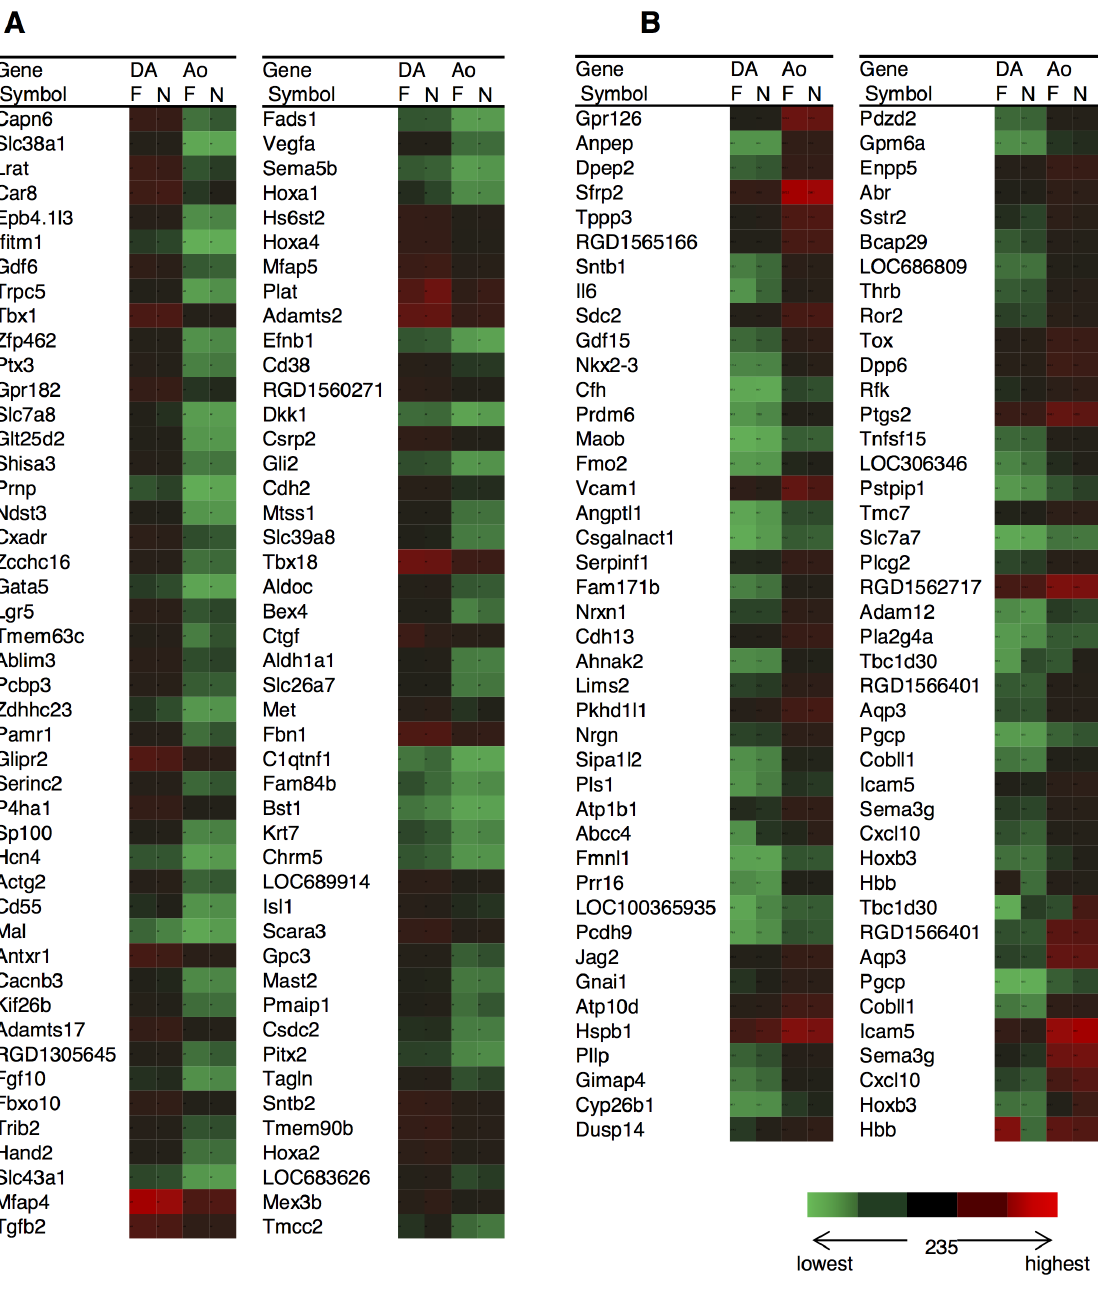
Figure 3. Color scale table imitating heat maps of DA dominant genes and Ao dominant genes. The listed genes in A) and B) are the same as in Table 2 and Table 3, respectively. The color scale is based on their expression intensities. The green or red color indicates the lowest or the highest expression levels, respectively. The midpoint shown as a dark color represents 235 since it is the average of whole gene expression.